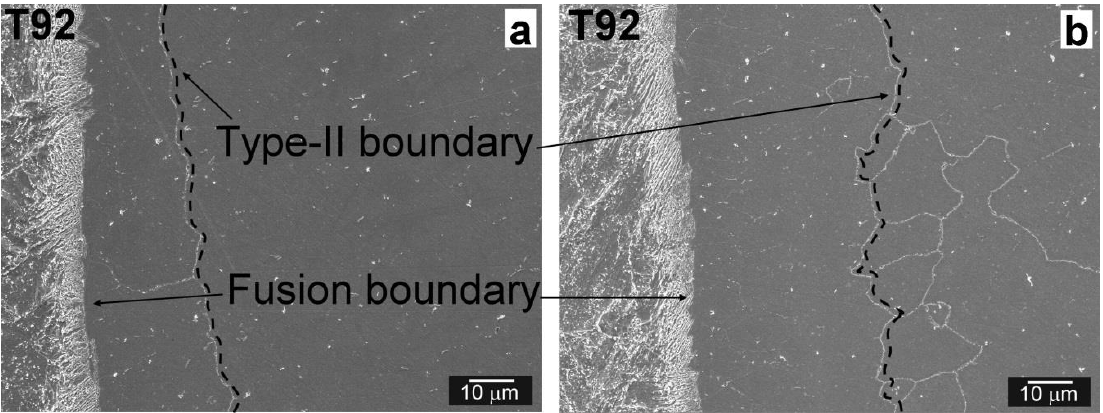
Figure 4. Microstructure of the Ni weld metal (WM) (Thermanit Nicro 82) region, states: QT PWHT ( a ); QT PWHT + 620 °C/2500 h ( b ).